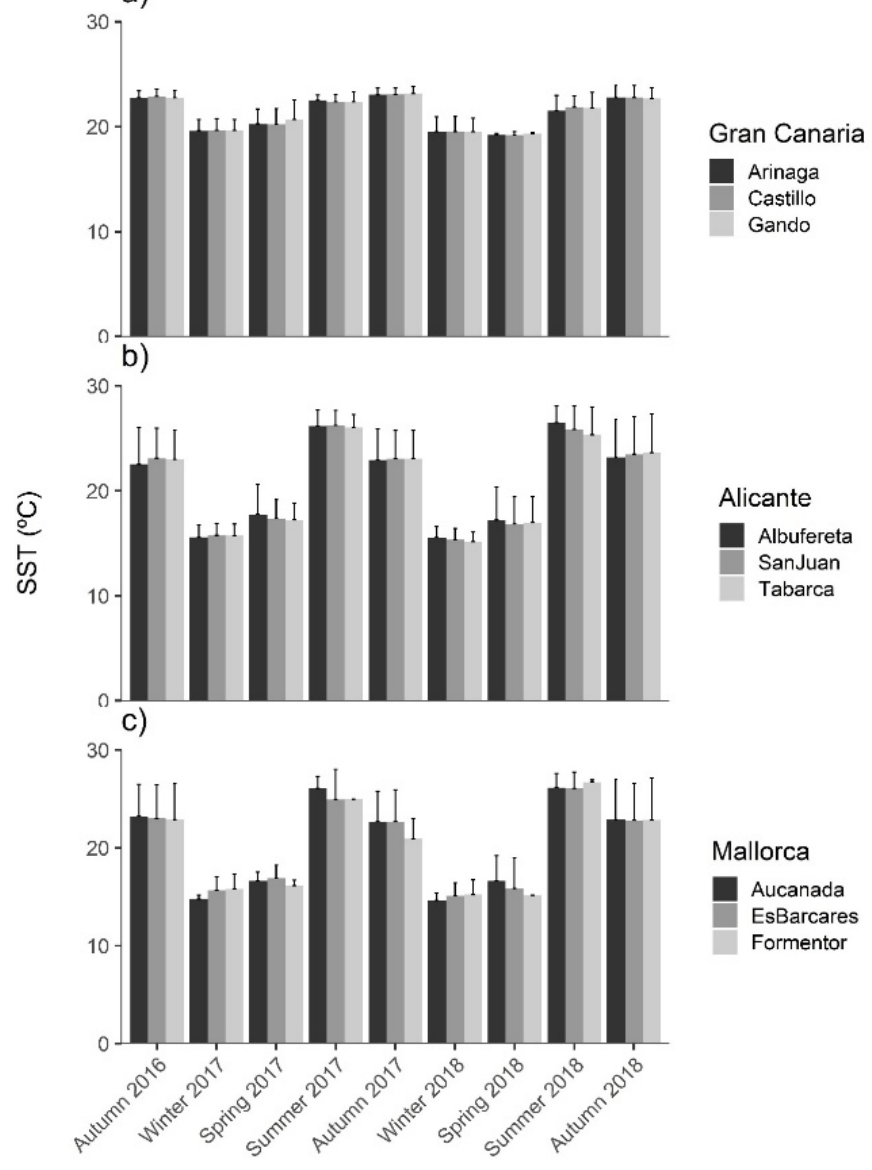
Figure 2. Mean seasonal Sea Surface Temperature (SST; °C) at each meadow from ( a ) Gran Canaria, ( b ) Alicante and ( c ) Mallorca throughout the study period. Error bars are + SD of means ( n = 9). Average of the three months per season between 2016–2018. The RDA separated meadows across regions, in varying seasons, according to ocean climate (mean seasonal SST) and seagrass structure (shoot density and seagrass surface area) along the first two axes of the ordination space, which accounted for ca. 80% of the total variation (Figure 3), with the axes (components) 1 and 2 explaining 53.1% and 30.1%